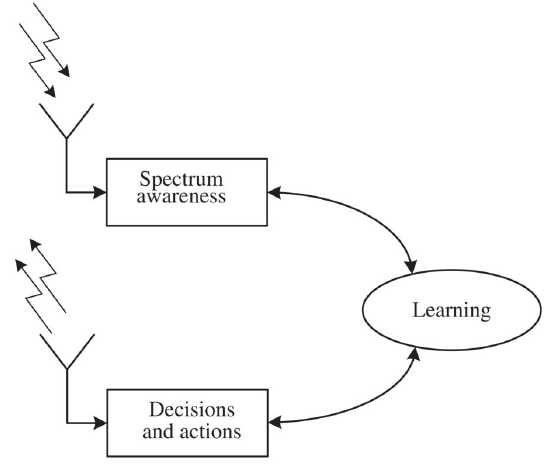
Figure 1. Functional model of